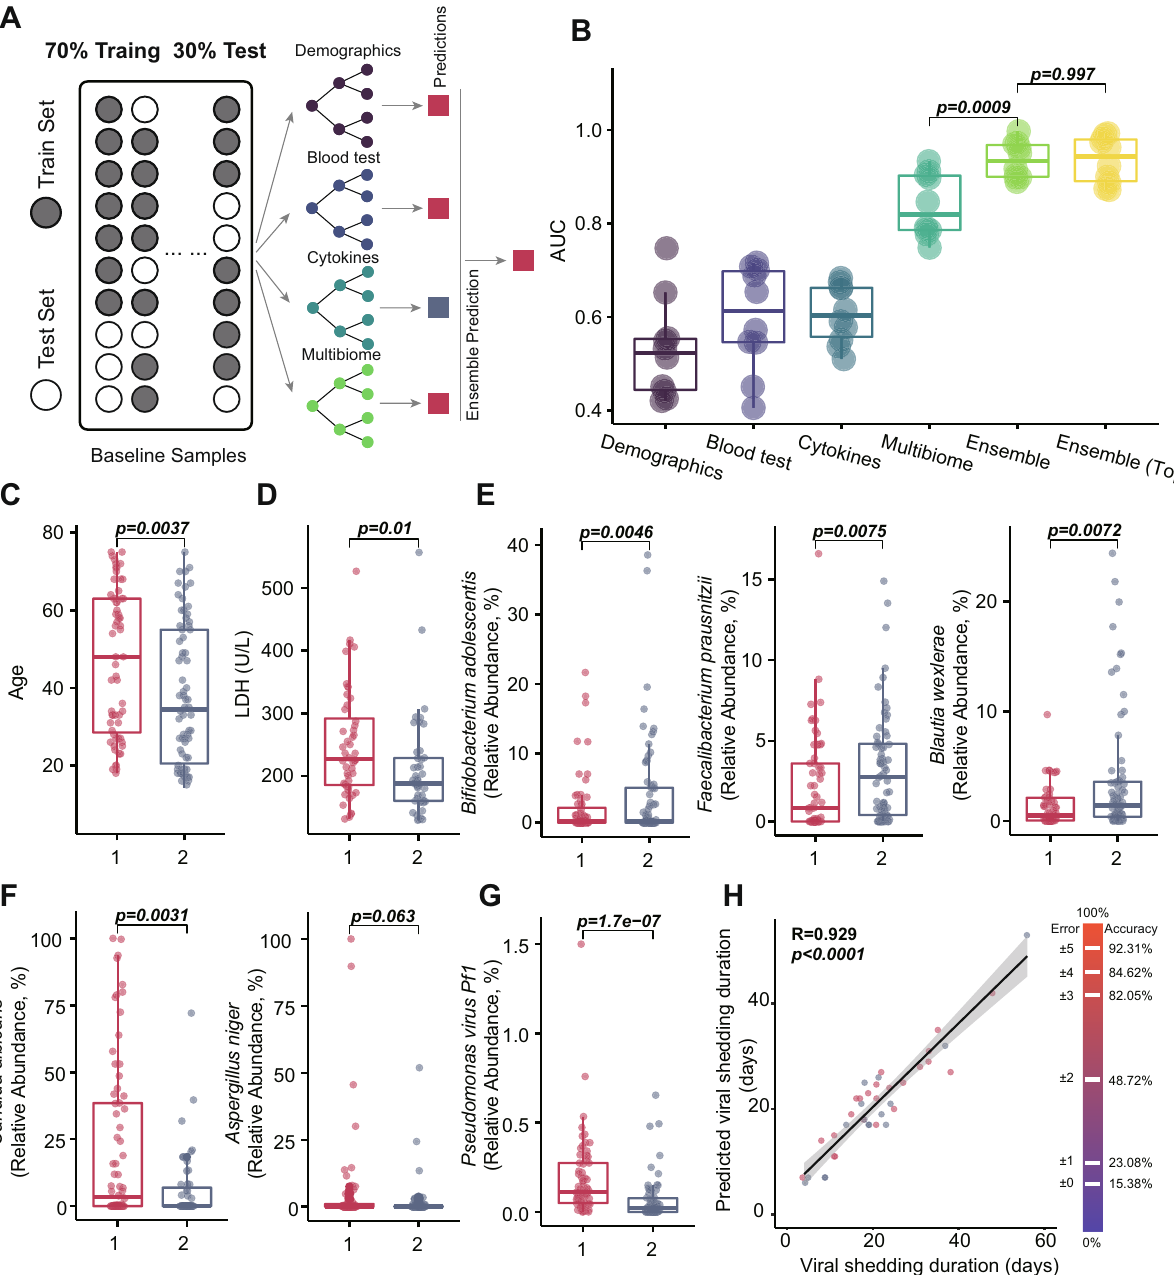
models. In C – G , the two-sided Wilcoxon test was used to check the differences between the two clusters. H Integration of multi-biome and clinical data for pre- dicting the duration of viral shedding of SARS-CoV-2. The predicted positive time waspairedwiththerealpositivetimeforaccuracyevaluation,andtheaccuracywas calculated at different error levels from ±0 to ±5 days. Error bands re fl ect the 95% CI. R and P values were calculated by two-sided Spearman Correlation, p <0.0001. In B – G , the horizontal line in the boxplot indicates the median value. Box plots lower and upper hinges correspond to the fi rst and third quartiles and upper and lower whiskers represent the highest and lowest values within 1.5 times the interquartile